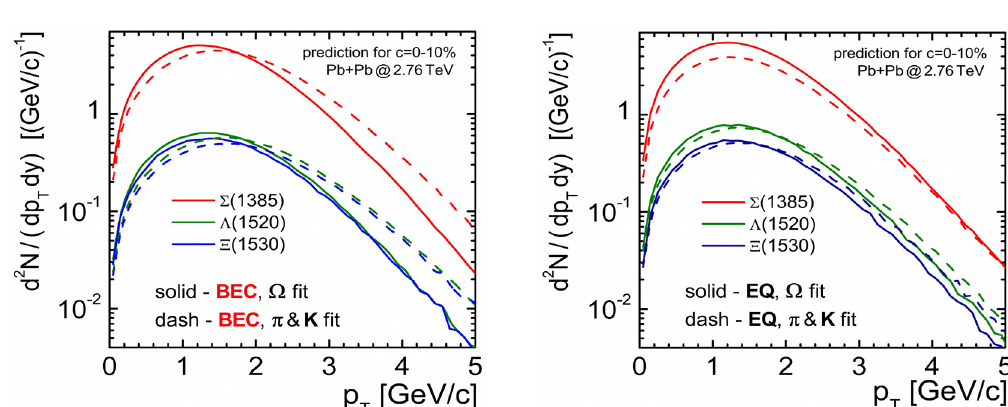
Figure 6. Prediction for the half-sum of Σ + (1385), Σ 0 (1385), Σ − (1385), and their anti-particles, as well as ( Λ 0 (1520) + Λ 0 (1520)) / 2, and ( Ξ 0 (1530) + Ξ 0 (1530)) / 2.